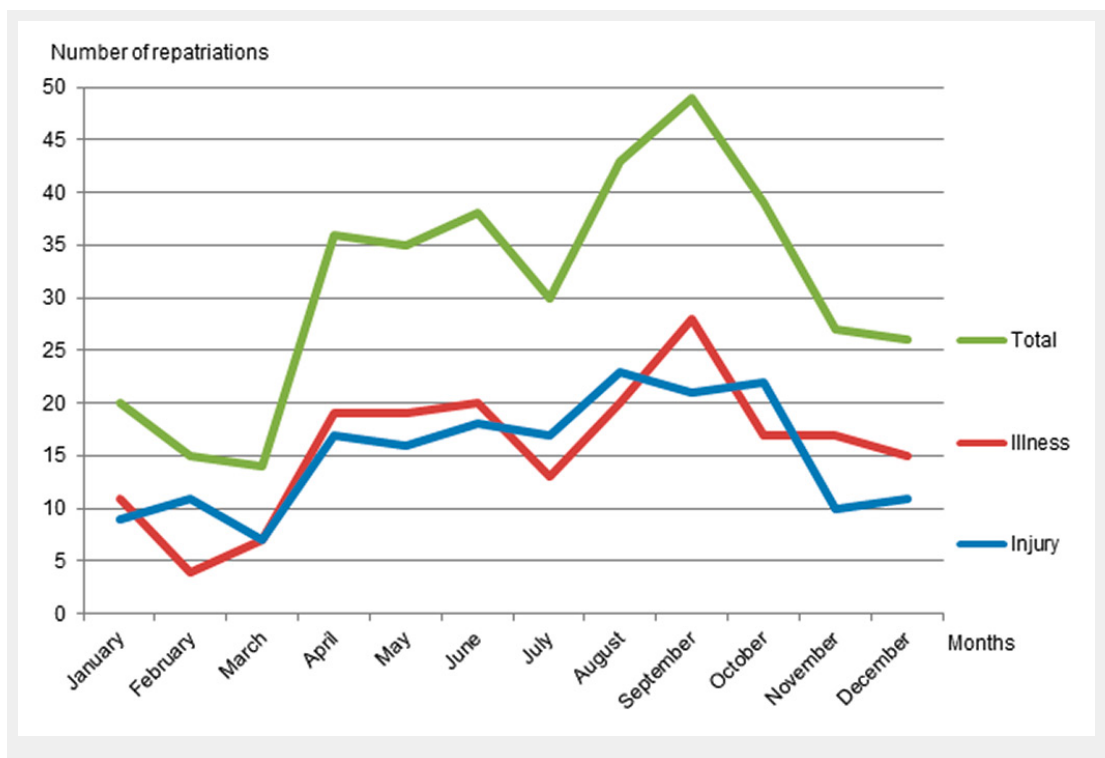
Repatriations per